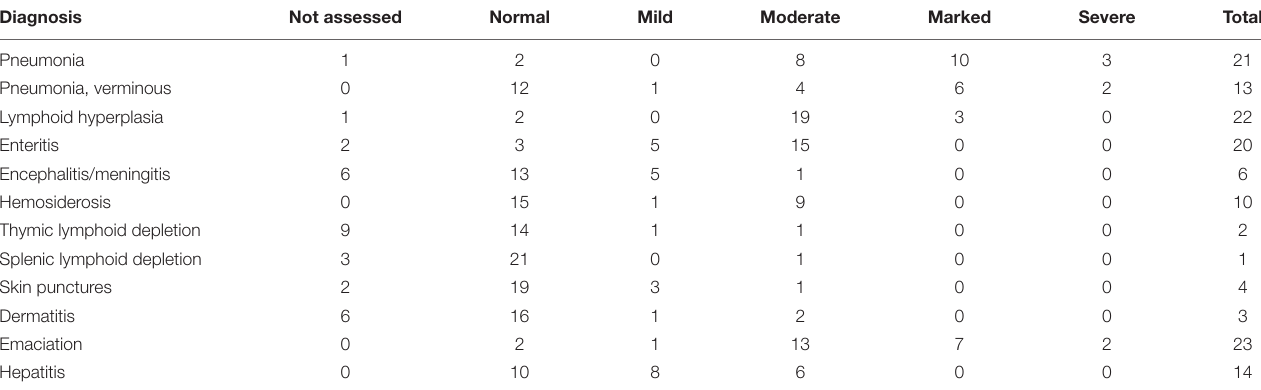
TABLE 2 | Summary of the most significant and consistently observed gross and histologic findings for 25 harbor seals that stranded in Washington State between October 2007 and July 2008. Diagnosis Not assessed Normal Mild Moderate Marked Severe Total